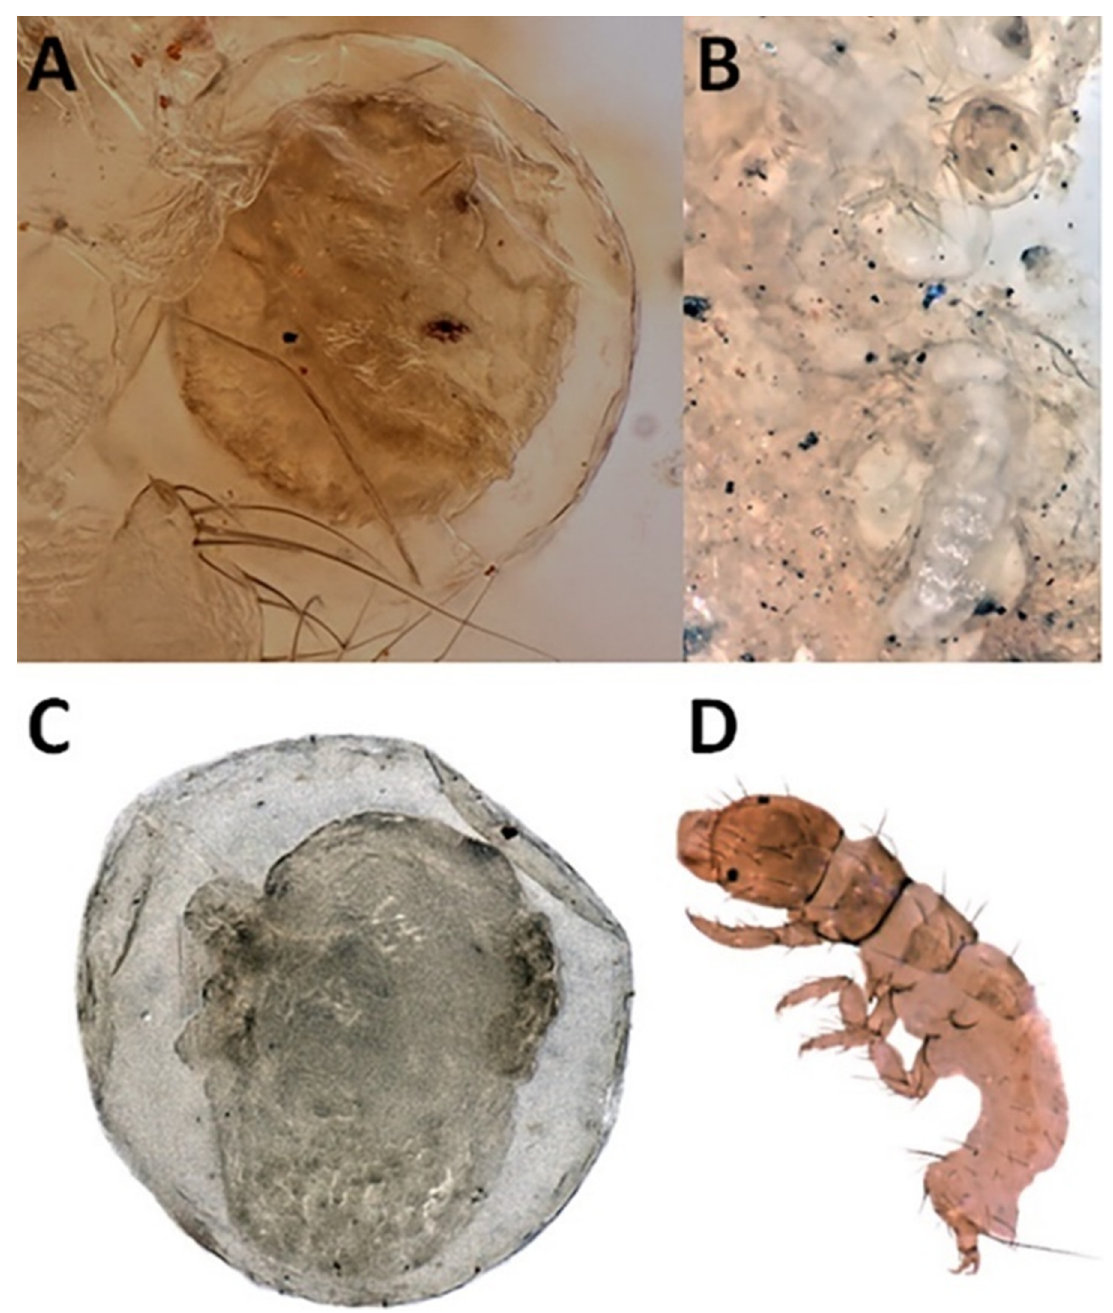
Figure 4. Early life stages of Hydropsyche alternans . ( A ) Egg, early embryo stage; ( B ) egg mass with developing eggs and newly hatched, unsclerotized, 1st instar larvae, which remain in the egg mass for a short time before emerging; sibling cannibalism is a major source of mortality during this period [65]; ( C ) egg, late stage embryo, its head is at the top, developing legs are visible along its sides; ( D ) fully sclerotized 1st instar larva.